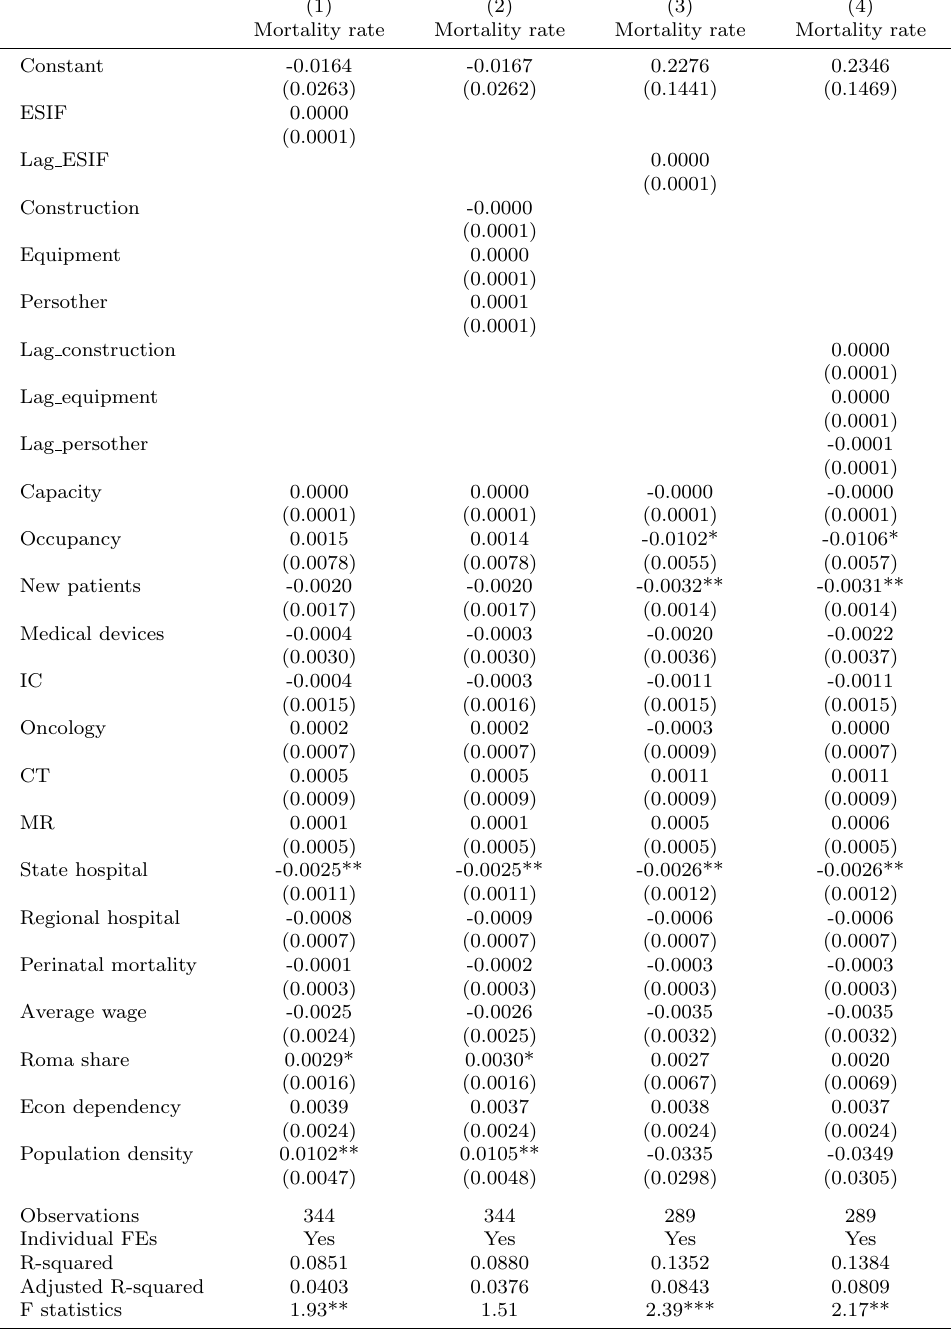
Table A.3: Contemporaneous and lagged effect of cumulative ESIF on the mortality rate – full